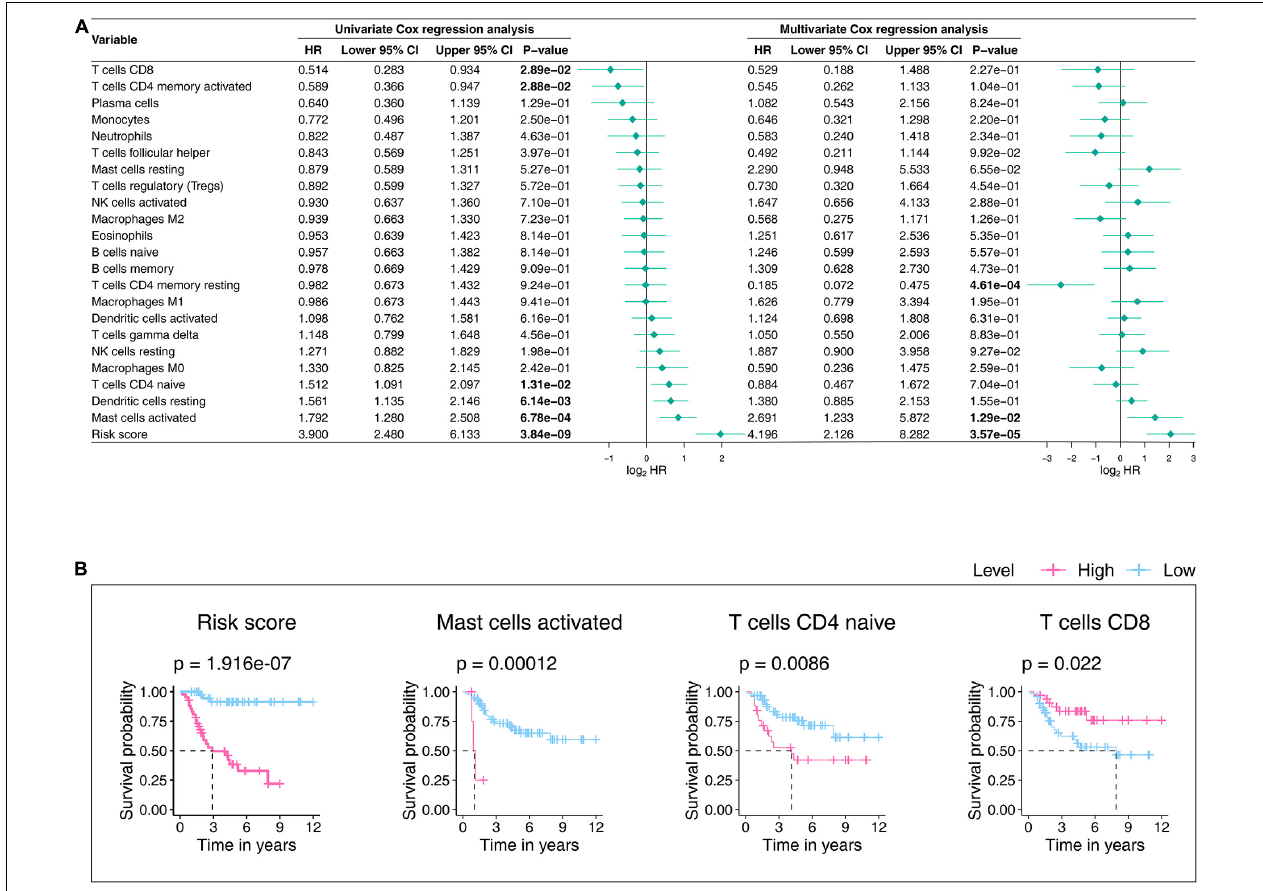
FIGURE 11 | Univariateand multivariate Cox proportionalhazards models (A) and Kaplan–Meier estimators (B) evaluate the 22 TICs’prognostic ability. (A) The bold p-value indicates that < 0.05. (B) In the established Kaplan–Meier estimators, we only selected those with a p-value less than 0.05 for display. A p -value < 0.05 was considered statistically significant; TIC, tumor-infiltrating immune